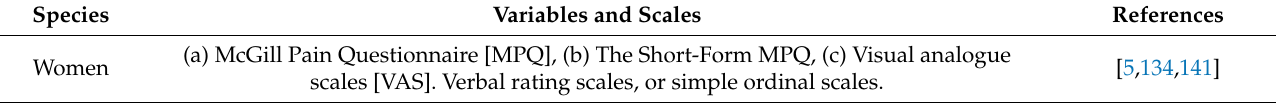
Table 5. Multi-parametric scales for assessing labour pain (behavioural indicators). Species Variables and